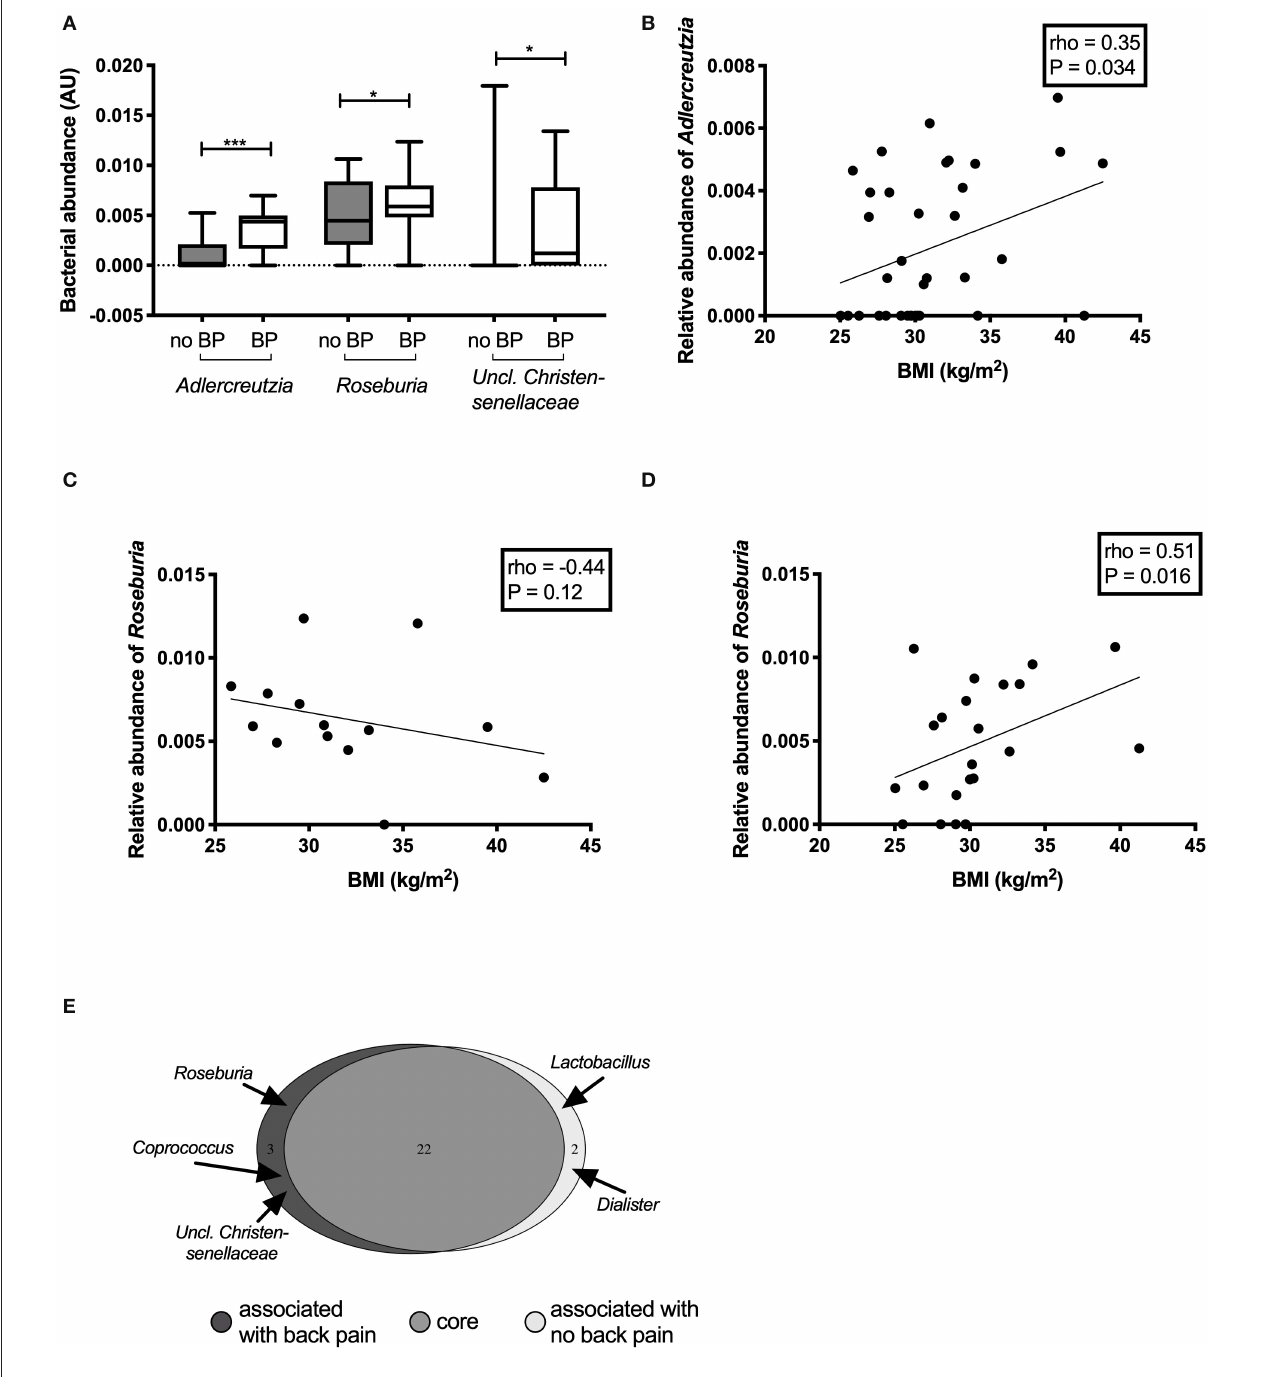
FIGURE 2 | Differentially abundant genera between individuals with and without back pain in the past month. Genera that were found to be significantly altered in the gut microbiota of individuals with back pain (BP) (A) . Correlations between the abundance of the genus Adlercreutzia and BMI (B) in all participants. Correlations between the abundance of the genus Roseburia and BMI in participants with back pain (C) and without back pain (D) . Bacteria that made up the core microbiome of the individuals in this study (E) .